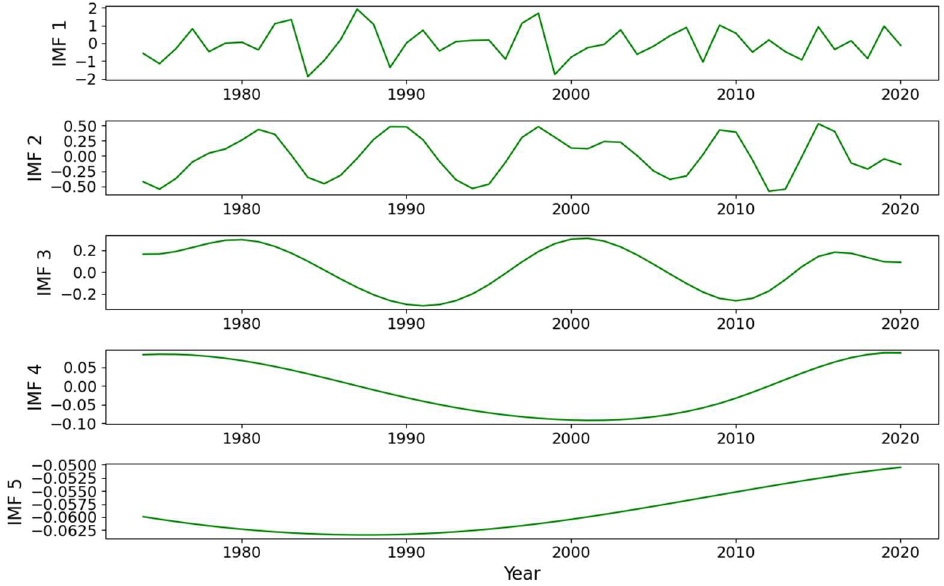
Figure 3. EEMD decomposition of SST time series in the tropical western Indian ocean.